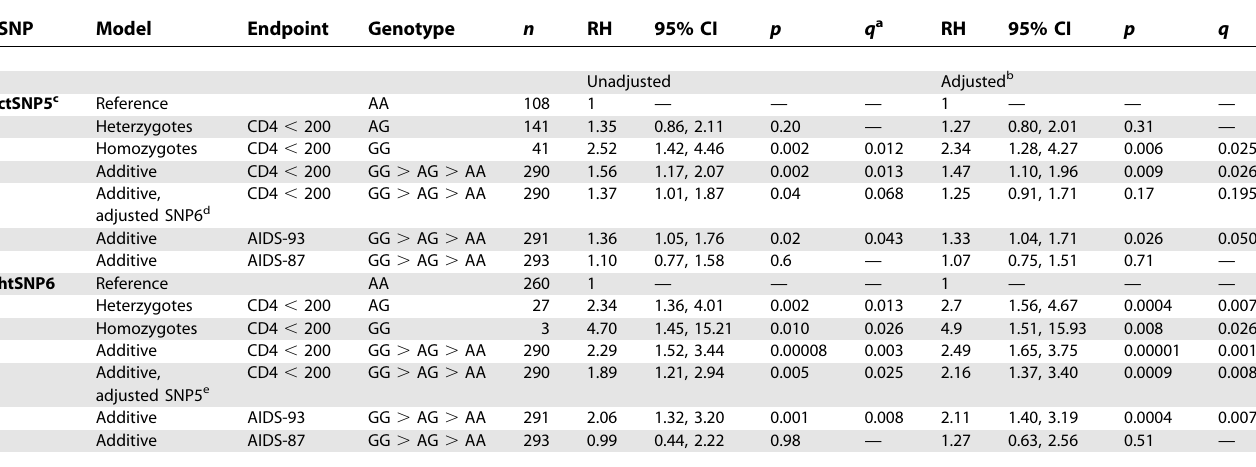
Table 1. Effects of CUL 5 SNPs on Progression to CD4 þ T Cells , 200 and AIDS in African Americans